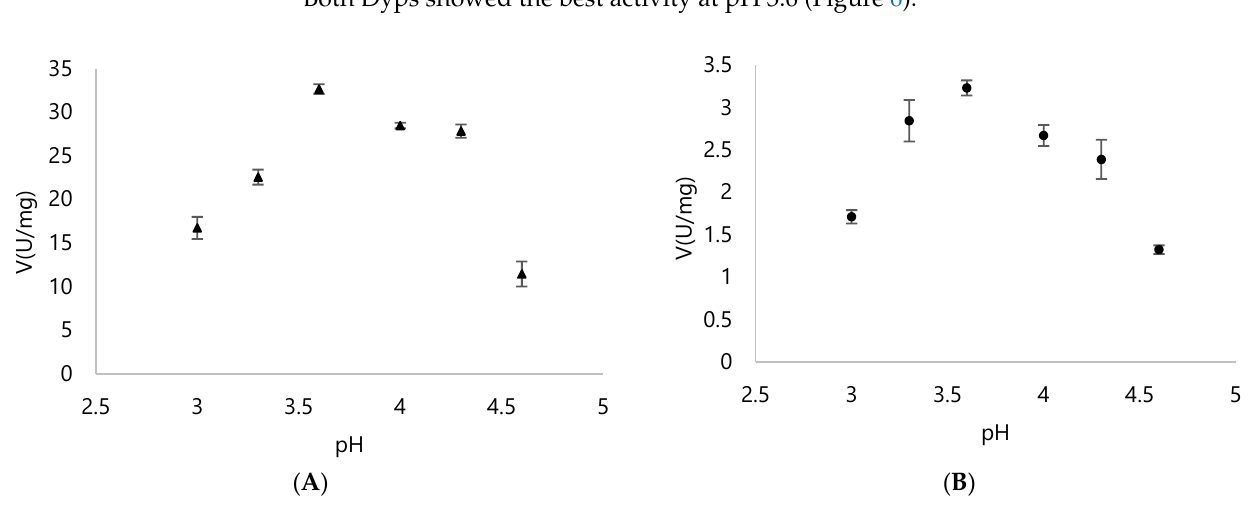
Figure 6. Specific activity of ( A ) DypA and ( B ) DypB with 144 µM RB5 as the substrate using 25 mM citrate buffer to check the optimal pH for each enzyme.